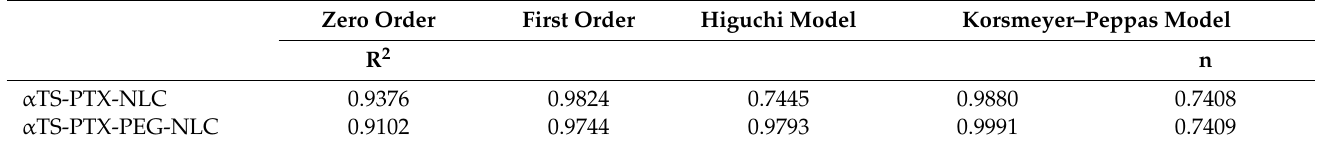
Table 8. Mathematical fitting (goodness of fit values (R 2 )) of the drug release of PTX from α TS-PTX- NLC and α TS-PTX-PEG-NLC